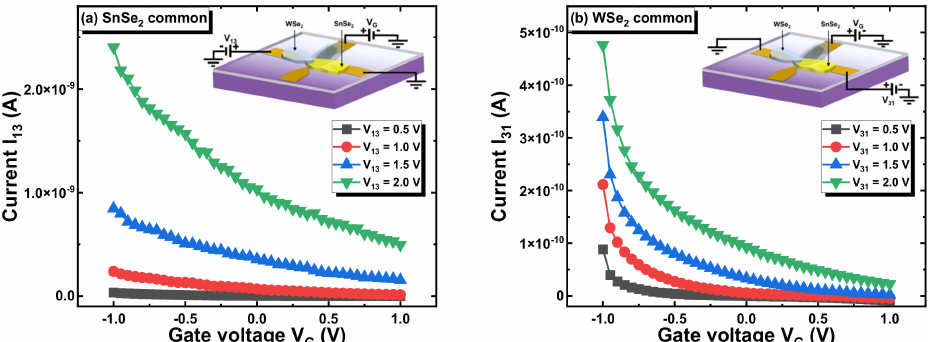
Figure 4. Gate voltage dependence of the current in BP-gated p-WSe 2 /n-SnSe 2 heterostructure with ( a ) common SnSe 2 and ( b ) common Wse 2